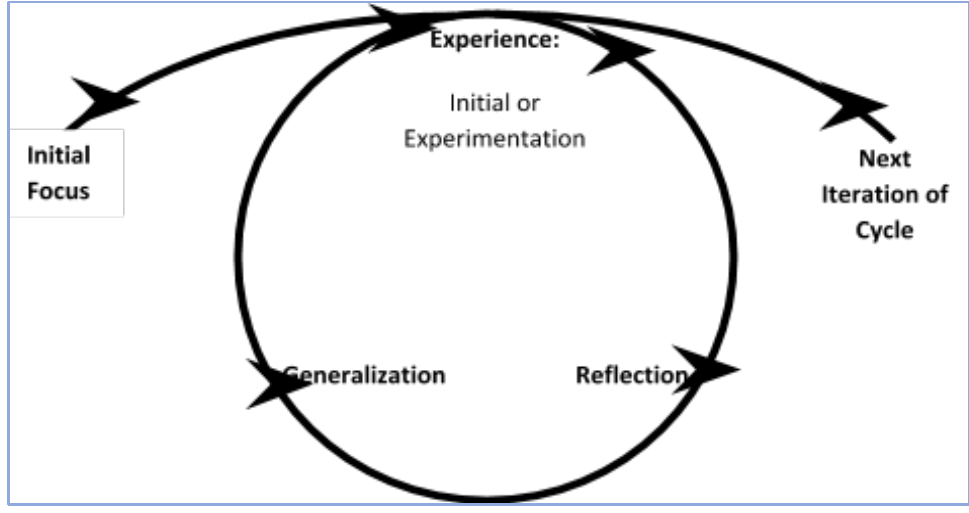
Figure 1. Experiential Learning Process (Roberts,